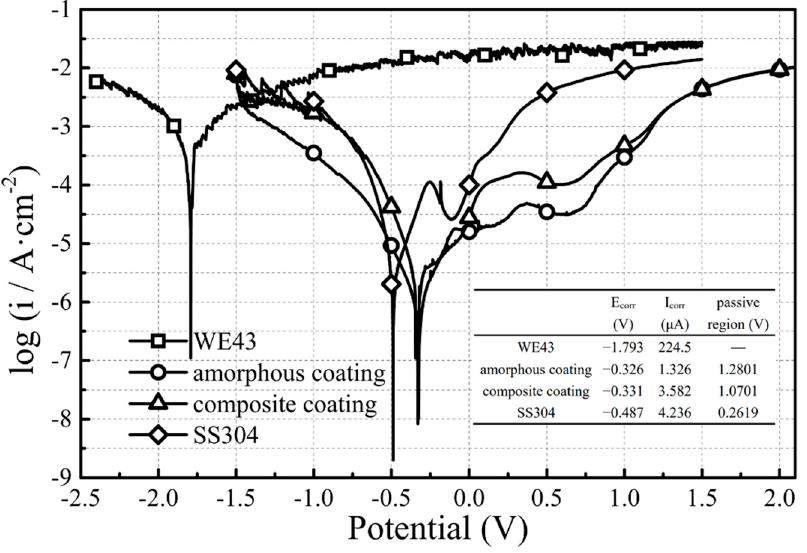
Figure 8. Tafel polarization plots of WE43, SS304 and amorphous coatings in 0.1 mol/L HCl solu-